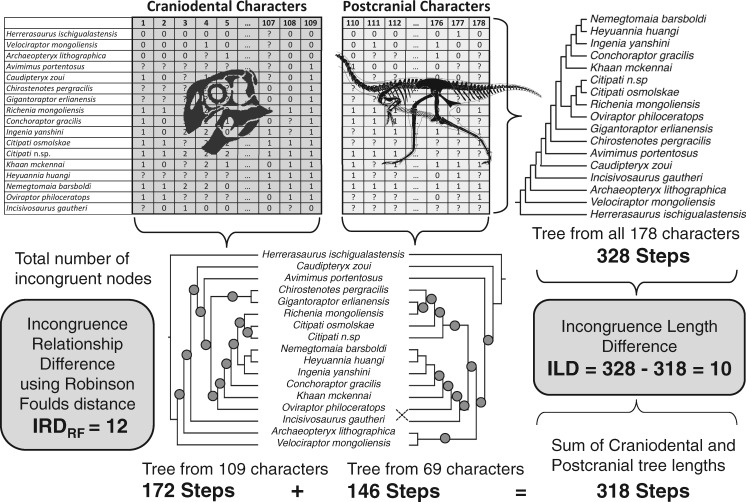
Calculation of the ILD and the IRD for the cranial and postcranial character partitions in the data of Fanti et al. (2012). Parsimony analysis of all 178 characters together yields a single MPT of 328 steps. Analysis of 109 craniodental characters alone yields an MPT length of 172 steps, while 69 postcranial characters alone yield an MPT length of 146 steps. The sum of these partitioned lengths (\documentclass[12pt]{minimal}
\usepackage{amsmath}
\usepackage{wasysym} 
\usepackage{amsfonts} 
\usepackage{amssymb} 
\usepackage{amsbsy}
\usepackage{upgreek}
\usepackage{mathrsfs}
\setlength{\oddsidemargin}{-69pt}
\begin{document}
}{}$172 + 146 =318$\end{document}) is less than the length of the global MPT by 10 steps (\documentclass[12pt]{minimal}
\usepackage{amsmath}
\usepackage{wasysym} 
\usepackage{amsfonts} 
\usepackage{amssymb} 
\usepackage{amsbsy}
\usepackage{upgreek}
\usepackage{mathrsfs}
\setlength{\oddsidemargin}{-69pt}
\begin{document}
}{}$328 - 318 = 10$\end{document}). This discrepancy is the incongruence length difference (ILD\documentclass[12pt]{minimal}
\usepackage{amsmath}
\usepackage{wasysym} 
\usepackage{amsfonts} 
\usepackage{amssymb} 
\usepackage{amsbsy}
\usepackage{upgreek}
\usepackage{mathrsfs}
\setlength{\oddsidemargin}{-69pt}
\begin{document}
}{}$=10$\end{document}). The partitioned trees imply different relationships, and the magnitude of this difference can be measured using a diversity of tree-to-tree distance metrics. The RF or symmetrical difference distance (Robinson and Foulds 1981) is among the most widely applied, and is calculated as the sum of the number of internal tree nodes that are present in one tree but not the other. The IRD\documentclass[12pt]{minimal}
\usepackage{amsmath}
\usepackage{wasysym} 
\usepackage{amsfonts} 
\usepackage{amssymb} 
\usepackage{amsbsy}
\usepackage{upgreek}
\usepackage{mathrsfs}
\setlength{\oddsidemargin}{-69pt}
\begin{document}
}{}$_{RF}$\end{document} is therefore the incongruence relationship difference measured using the RF distance. The RF distance has the disadvantage that it can saturate quickly. Numerous other tree-to-tree distance metrics are available, and we also implement the matching distance here (MD) (Lin et al. 2012), to yield the IRD\documentclass[12pt]{minimal}
\usepackage{amsmath}
\usepackage{wasysym} 
\usepackage{amsfonts} 
\usepackage{amssymb} 
\usepackage{amsbsy}
\usepackage{upgreek}
\usepackage{mathrsfs}
\setlength{\oddsidemargin}{-69pt}
\begin{document}
}{}$_{matching}$\end{document}. The ILD, IRD\documentclass[12pt]{minimal}
\usepackage{amsmath}
\usepackage{wasysym} 
\usepackage{amsfonts} 
\usepackage{amssymb} 
\usepackage{amsbsy}
\usepackage{upgreek}
\usepackage{mathrsfs}
\setlength{\oddsidemargin}{-69pt}
\begin{document}
}{}$_{RF}$\end{document}, and IRD\documentclass[12pt]{minimal}
\usepackage{amsmath}
\usepackage{wasysym} 
\usepackage{amsfonts} 
\usepackage{amssymb} 
\usepackage{amsbsy}
\usepackage{upgreek}
\usepackage{mathrsfs}
\setlength{\oddsidemargin}{-69pt}
\begin{document}
}{}$_{matching}$\end{document} each enables a test of incongruence, implemented by randomly partitioning the data set into character sets of the same size as the original (here, 109 and 69) and recalculating the metric. This is repeated a large number of times to yield a null distribution for randomized metric values, and the value for the original partition is compared with this in order to yield an empirical \documentclass[12pt]{minimal}
\usepackage{amsmath}
\usepackage{wasysym} 
\usepackage{amsfonts} 
\usepackage{amssymb} 
\usepackage{amsbsy}
\usepackage{upgreek}
\usepackage{mathrsfs}
\setlength{\oddsidemargin}{-69pt}
\begin{document}
}{}$P$\end{document} value. Because the ILD, IRD\documentclass[12pt]{minimal}
\usepackage{amsmath}
\usepackage{wasysym} 
\usepackage{amsfonts} 
\usepackage{amssymb} 
\usepackage{amsbsy}
\usepackage{upgreek}
\usepackage{mathrsfs}
\setlength{\oddsidemargin}{-69pt}
\begin{document}
}{}$_{RF}$\end{document}, and IRD\documentclass[12pt]{minimal}
\usepackage{amsmath}
\usepackage{wasysym} 
\usepackage{amsfonts} 
\usepackage{amssymb} 
\usepackage{amsbsy}
\usepackage{upgreek}
\usepackage{mathrsfs}
\setlength{\oddsidemargin}{-69pt}
\begin{document}
}{}$_{MD}$\end{document} all measure different things (tree length vs. different aspects of tree shape and relationships), the results of these tests do not invariably coincide. Silhouette modified from: https://en.m.wikipedia.org/wiki/File:Gigantoraptor_skeletal.png.